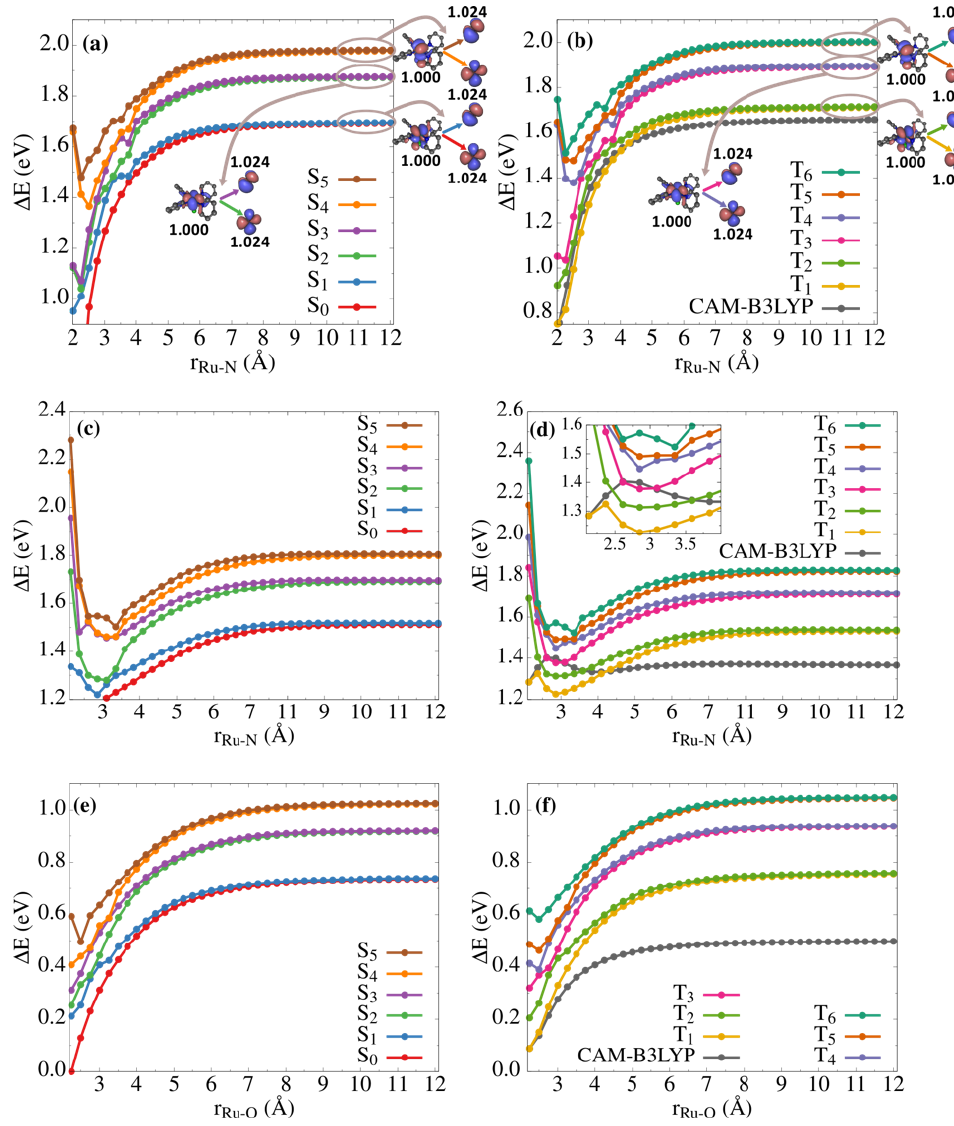
Figure 4. CASPT2 potential energy profiles along the Ru – NO or Ru – ON photodissociation for singlet states ( a , c , e ) and triplet states ( b , d , f ). Top, middle and bottom panels refer to photodissociation from 3 GS, 3 MS2 and 3 MS1, respectively. The zero energy is set to the S 0 electronic state. The CAM-B3LYP result is shown in ( b , d , f ) for each isomer. The hole / particle CASSCF molecular orbitals are also shown for each pair of degenerate states at the asymptotic limit along with their state-specific occupation numbers indicated in bold.